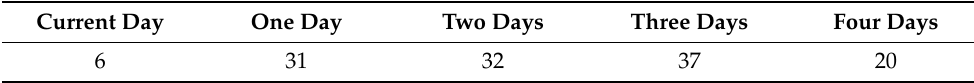
Table 2. Test data are classified by an experienced tomato